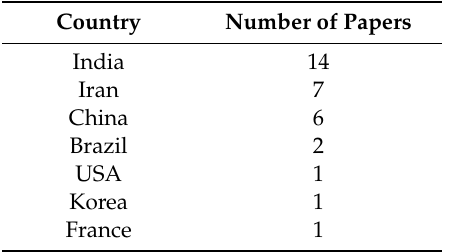
Table 3. Number of articles for particular countries.